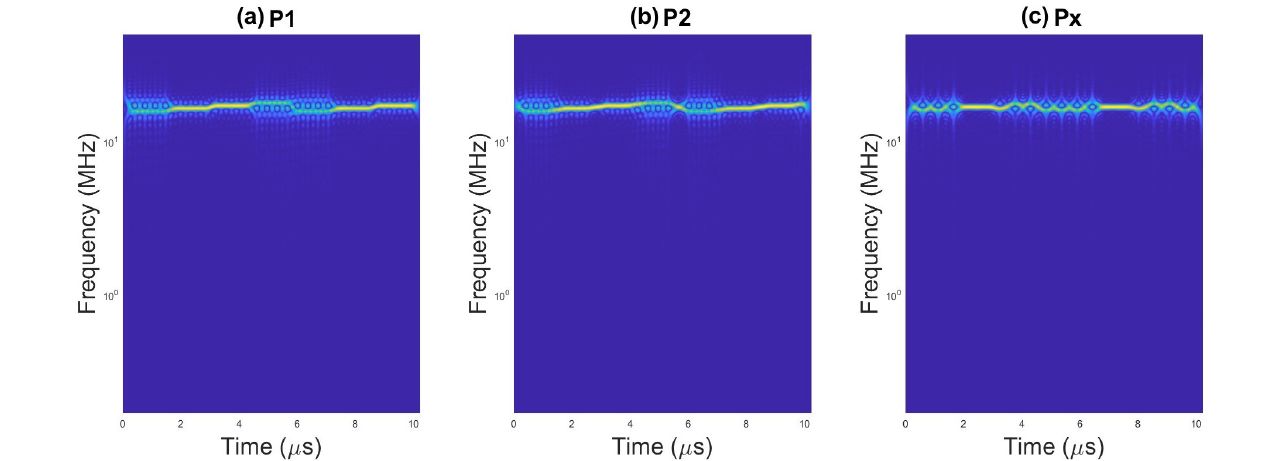
Figure 6. WVD for ( a ) pulse with Barker code; ( b ) pulses with Frank code.